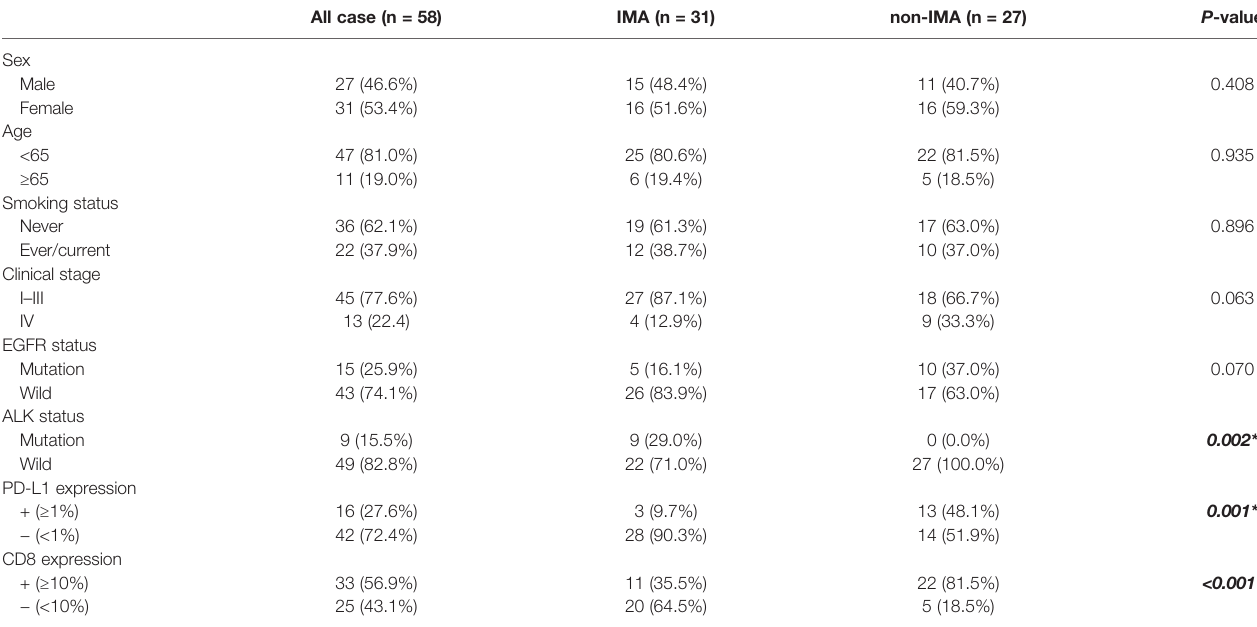
TABLE 1 | Clinicopathological characteristics of the 58 patients with lung